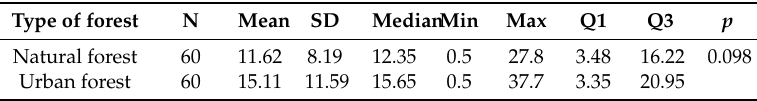
Figure 1. Medians, quartiles and ranges of values for S relative to location; S, canopy water storage capacity. Table 2. Analysis of the impact of location on S (g/g).